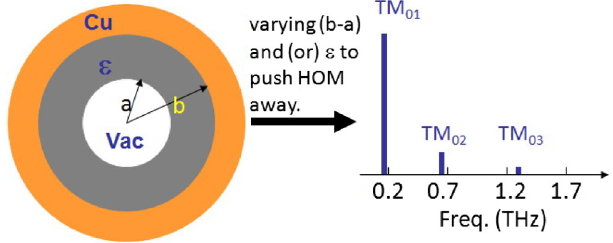
FIG. 7. Comparison of the double-triangular (red solid) and Gaussian (blue dot) bunch with 6 (cid:7) length of the Gaussian bunch and T is the total bunch length of the double-triangular bunch: (a) time domain; (b) frequency